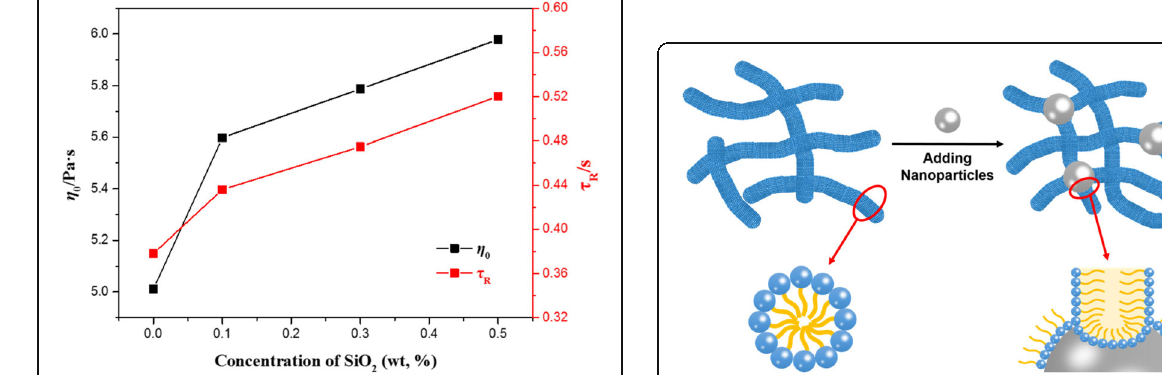
Fig. 5 Illustration of the proposed mechanism of a complex cross-linking networks constructed by wormlike micelles and silica